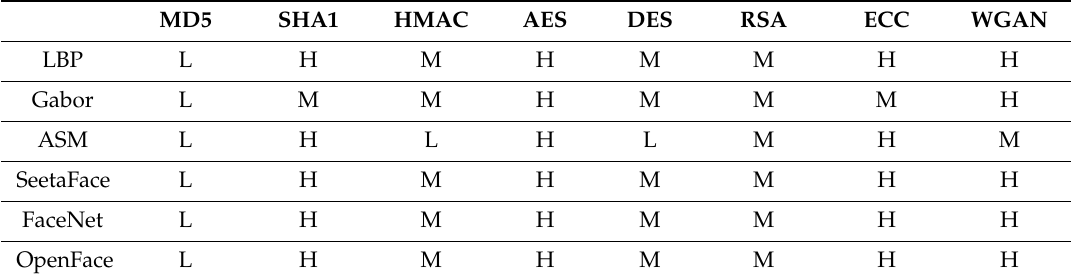
Table 3. Anti-cryptanalysis (L, Low; M, Medium; H, High).